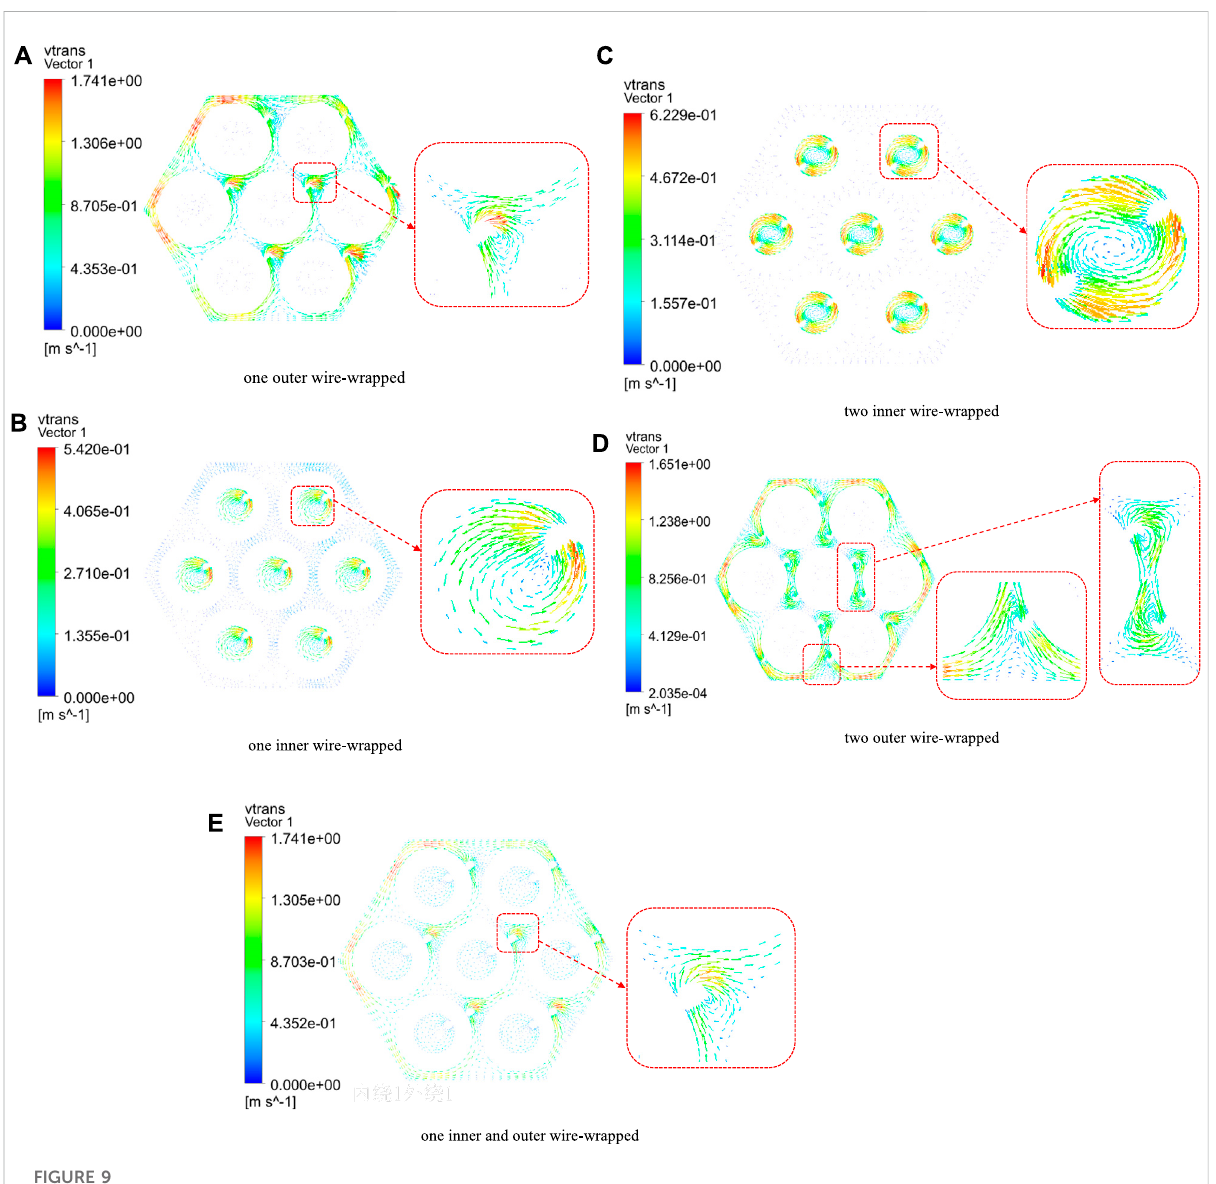
FIGURE 9 Velocity vector of the transverse velocity of cross-session with different